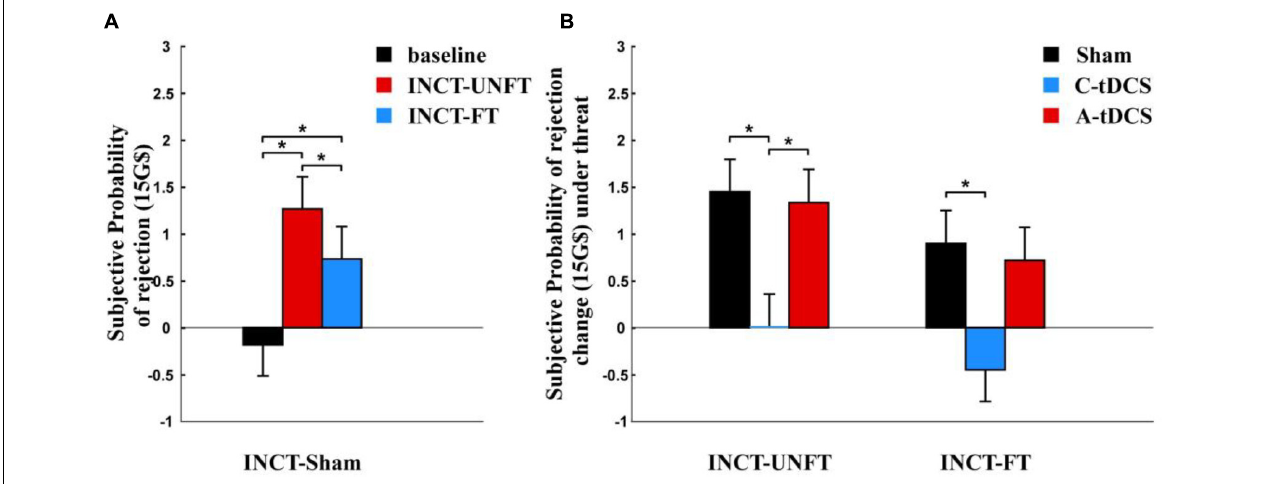
FIGURE 3 | Subjective probability change of rejection after incredible threat. (A) Mean subjective probability of rejection and the standard error in the sham group. (B) Effects of tDCS and fairness on subjective probability change of rejection and the standard error in the cathodal (C-tDCS), anodal (A-tDCS), and sham stimulation group at each fairness level. The interaction was not significant between fairness and stimulation. ∗ p <